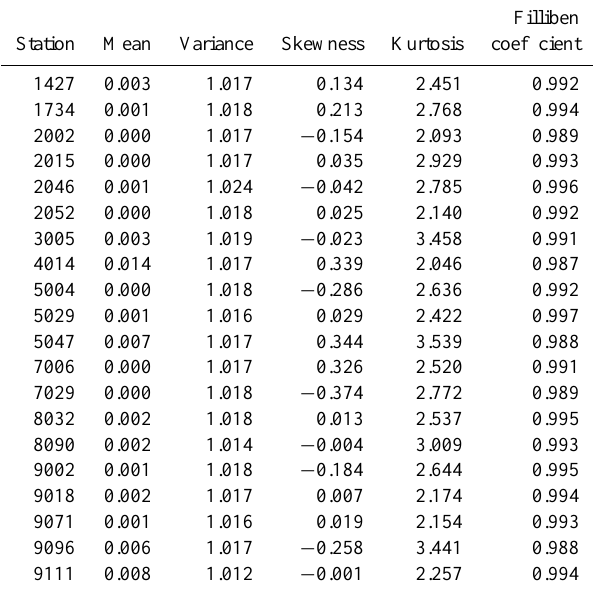
Table 6. Residuals moments for model 2 (external forcings as co- variates) and computed Filliben